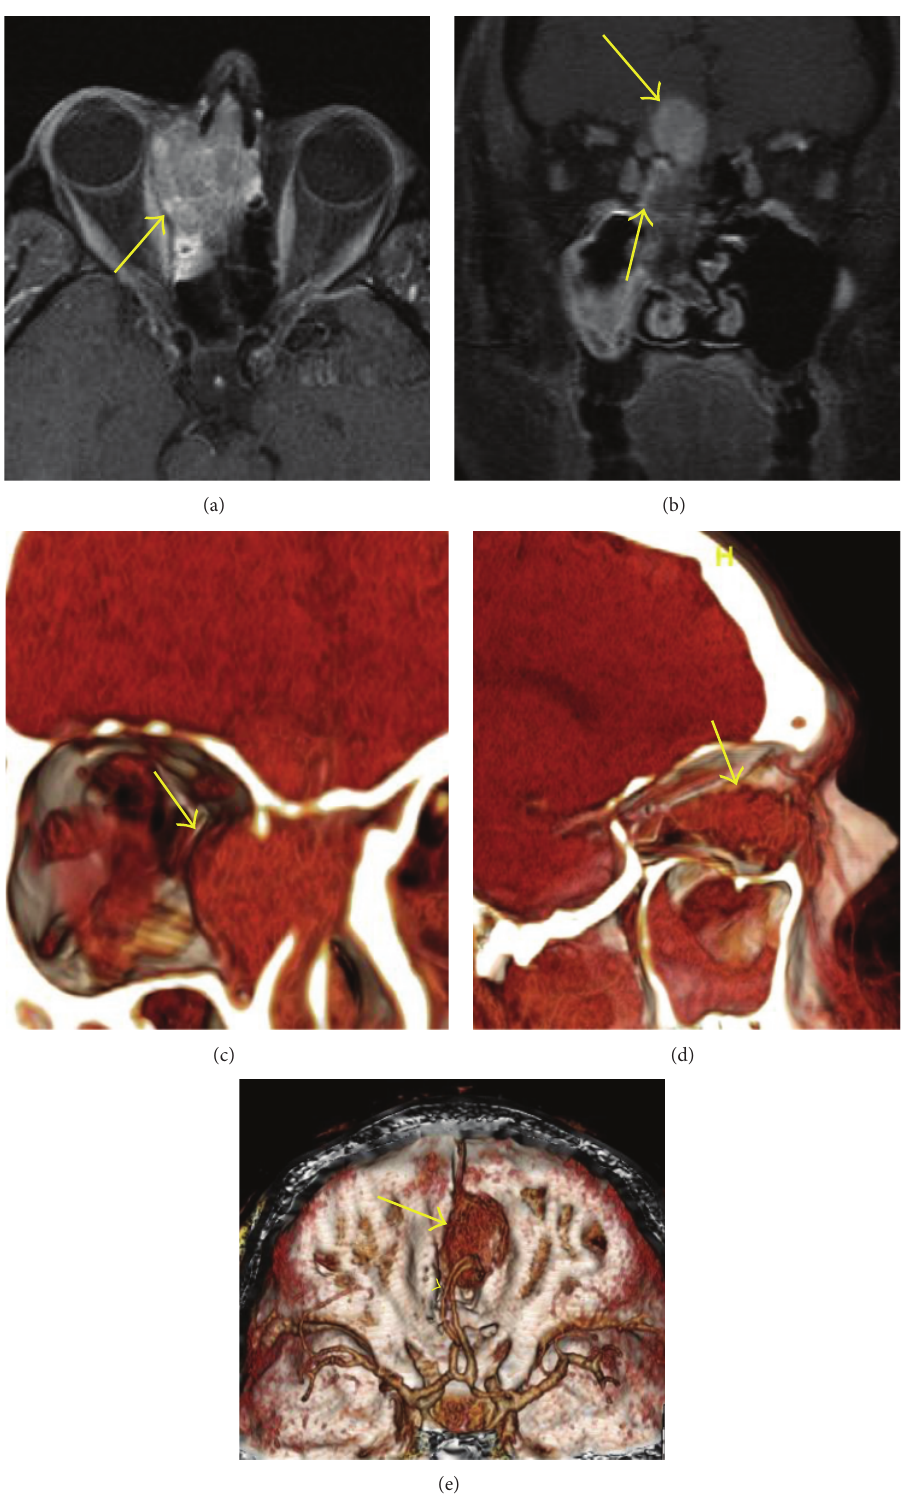
Figure 2: 46-year-old man with sinonasal neuroendocrine carcinoma. (a) Axial T1 postcontrast MRI shows the tumor in the right sinonasal cavity with extension through the lamina papyracea into the left orbit (arrow). (b) Coronal T1 postcontrast MRI shows tumor extending into the anterior cranial fossa (arrow). (c) 3D image gives a frontal view of the sinonasal tumor with orbital extension and medial displacement of the medial rectus muscle (arrow). (d) 3D image that has been rotated; the lateral orbital wall, optic nerve, and extraocular muscles have been removed to demonstrate a lateral view of the tumor (arrow). (e) 3D image giving a view from above the tumor in the anterior cranial fossa (arrow). Note the anterior cerebral arteries